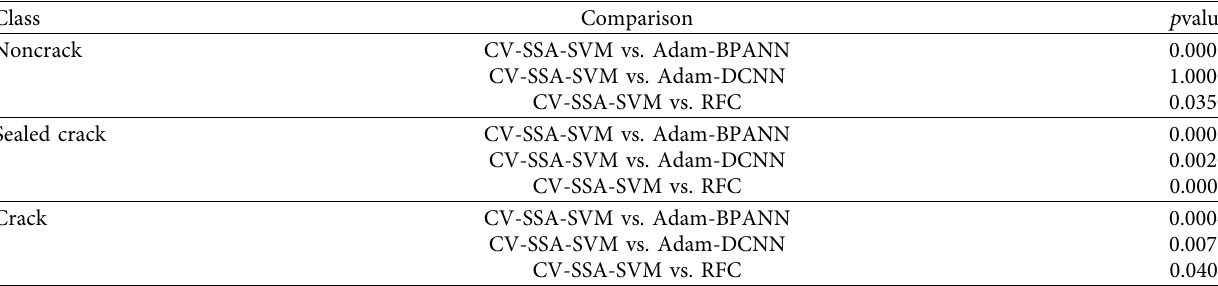
Table 3: p values obtained from the Wilcoxon signed rank test results.